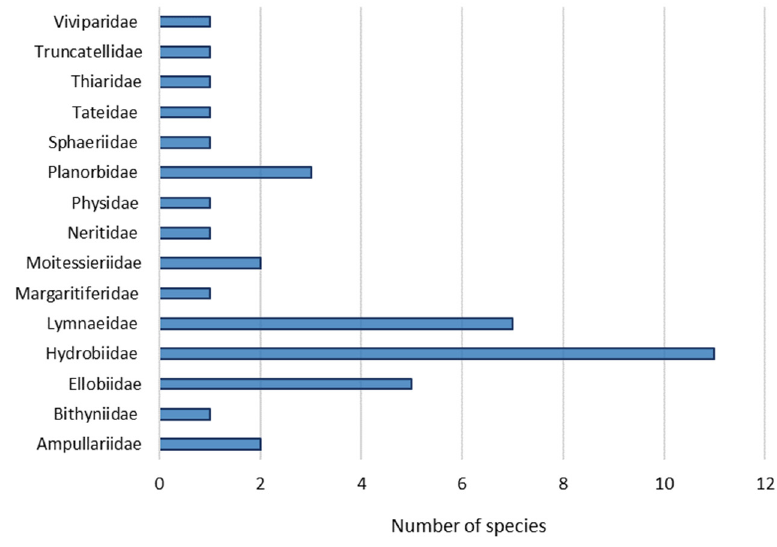
Figure 4. Diversity of species of the different freshwater mollusc families recorded in Asturias.